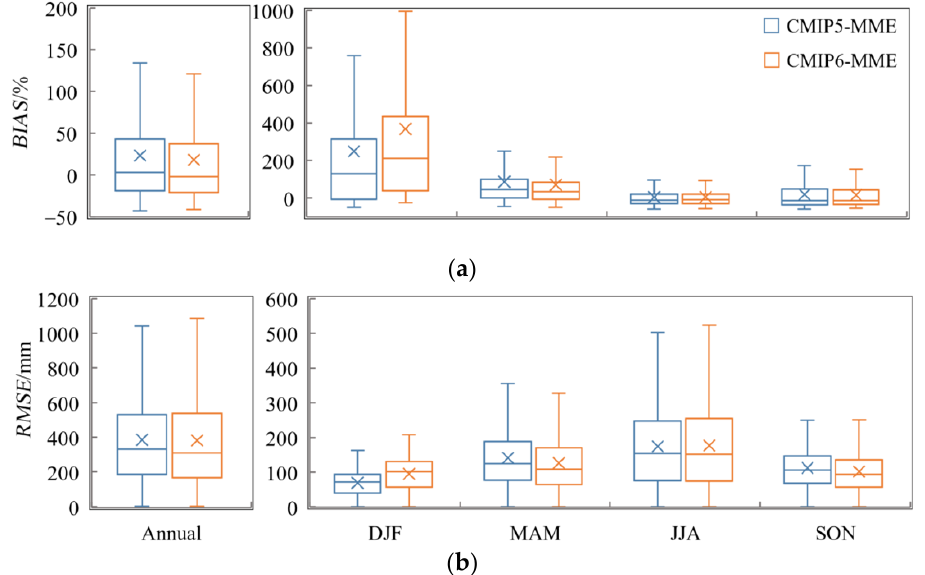
Figure 5. Box plots of relative bias ( a ) and root-mean square error ( b ) (projection minus observation) in CMIP5-MME and CMIP6-MME of annual and seasonal precipitation for the period 2015 –